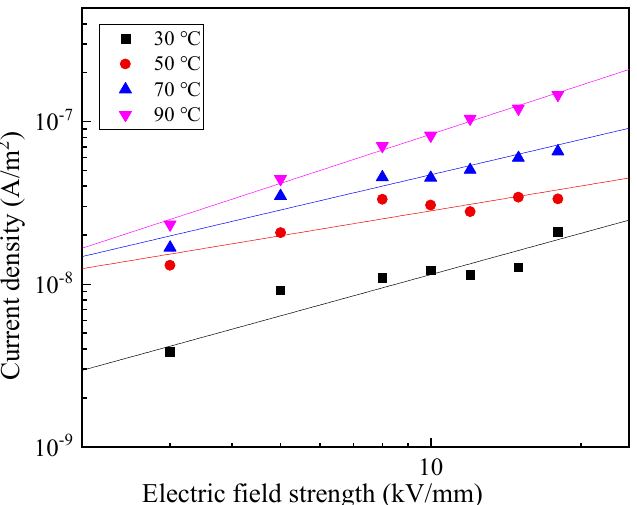
Figure 3. The quasi-steady current density of Al 2 O 3 ceramic at different temperatures and fields.